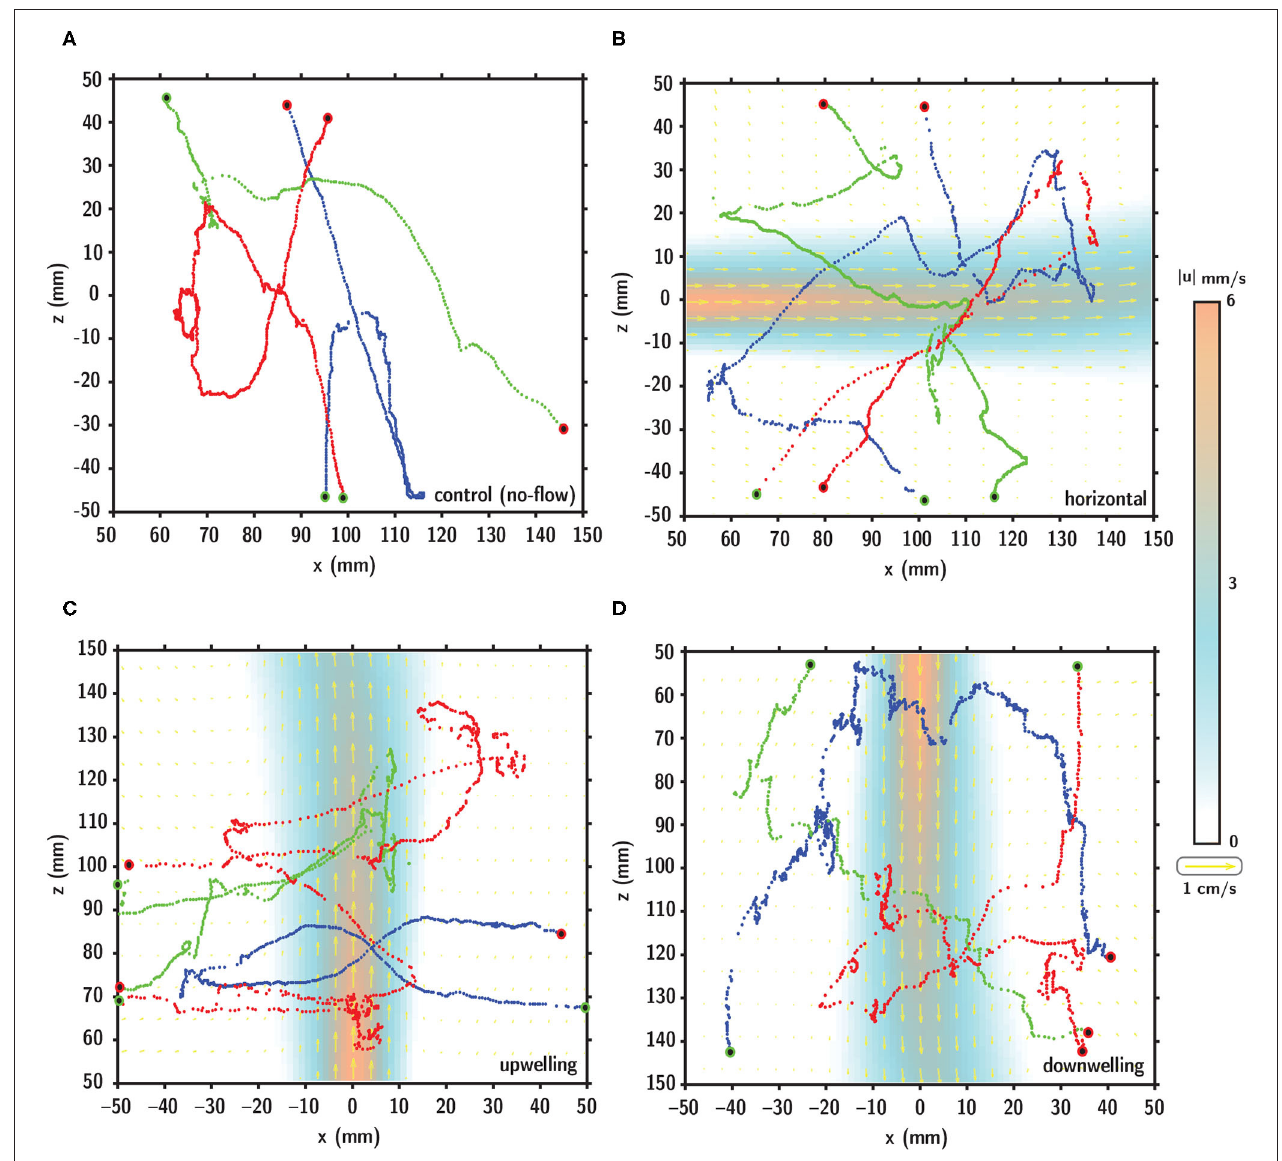
FIGURE 7 | Digitized larval swimming trajectories in (A) no-flow (control), (B) horizontal, (C) upwelling, and (D) downwelling shear flow configurations. In (B–D) , the shear layer is denoted by the velocity vectors (yellow) and velocity magnitude contours (orange to blue). In each panel, the starting and ending points of the trajectory are indicated by the green and red dots,